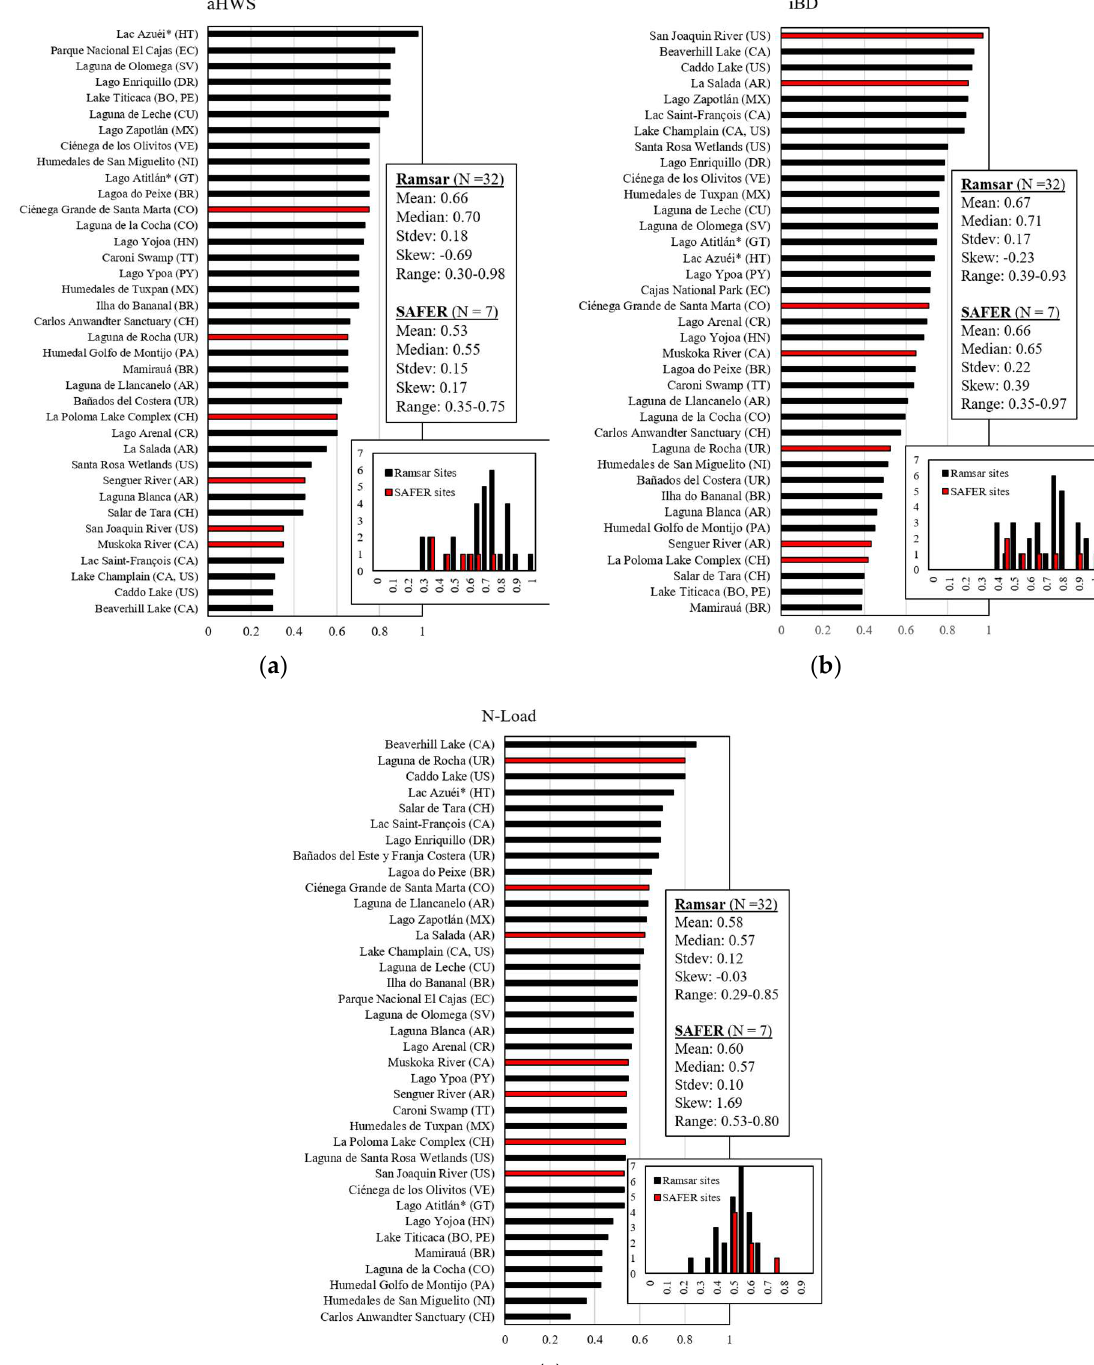
Figure 3. Estimated normalized FWES threat benchmark values and summary statistics for water supply (aHWS, a ), biodiversity-related services (iBD, b ), and nutrient regulation (N-load, c ) for Ramsar (black bars) and SAFER sites (red bars). Inset graphs are frequency histograms for the same values (0.05 bins).